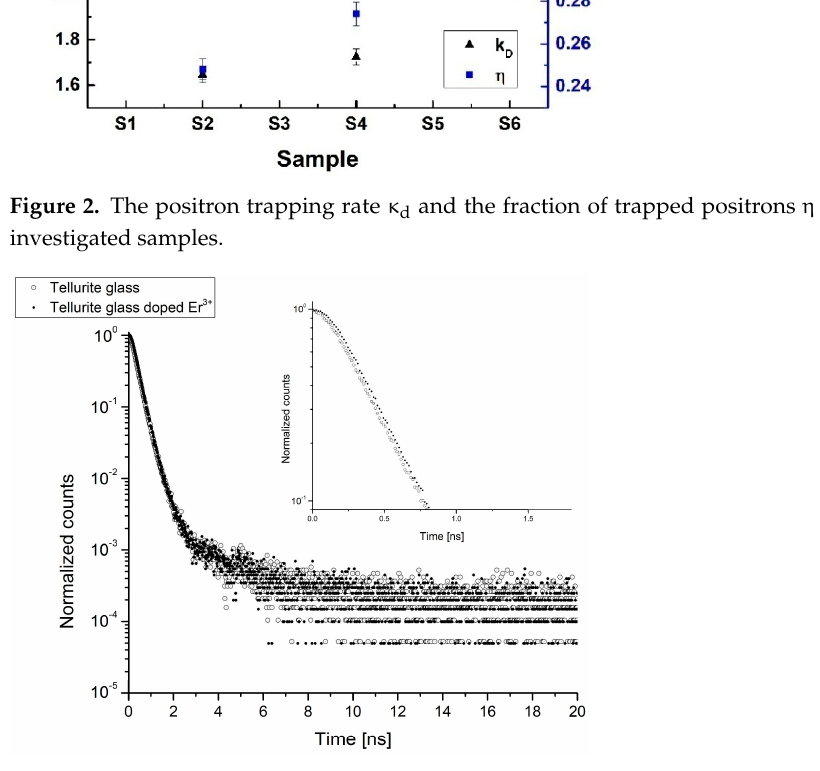
Figure 3. Exemplary experimental PALS spectra measured for tellurite glass and tellurite glass doped with Er 3+ ions.